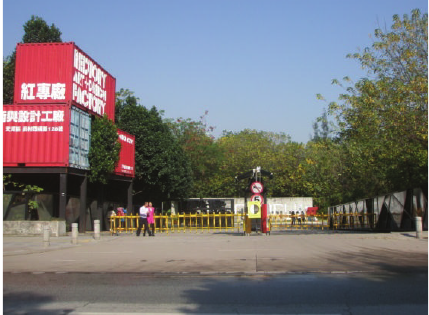
Figure 14: The gate of Redtory.